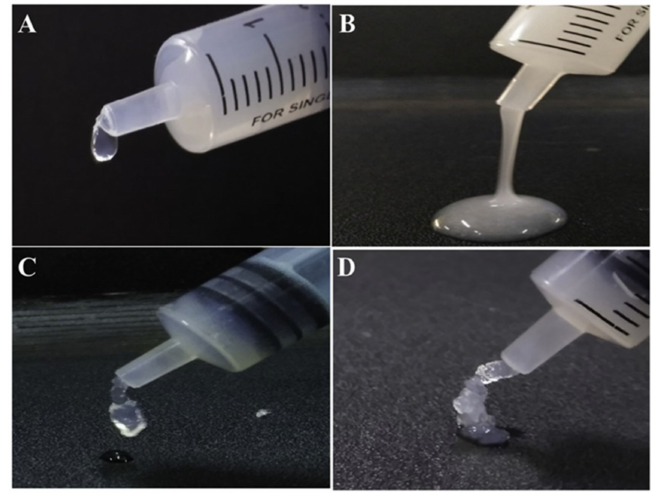
Figure 4. ( A , B ) The injectable HYH–HAP hydrogel and ( C , D ) the HYH–HAP–silk fibroin hydrogel form a three-dimensional gel scaffold. Reproduced with permission [39]. Copyright Elsevier, 2021.